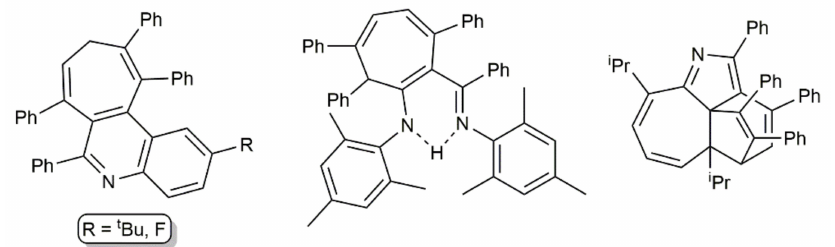
Figure 10. Other products generated from 1,4-diphenyl-1,3-butadiyne and anilines using the calciate catalyst [K 2 Ca{N(H)Dipp} 4 ].